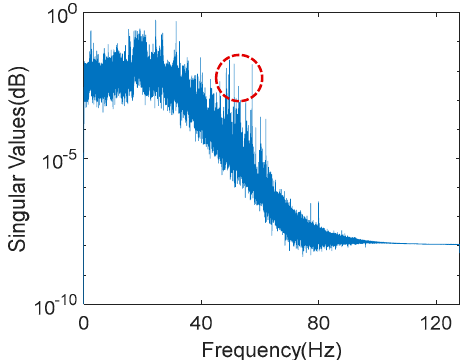
Figure 3. The singular value plot of the frequency domain decomposition of all the channels of a typical acceleration record.